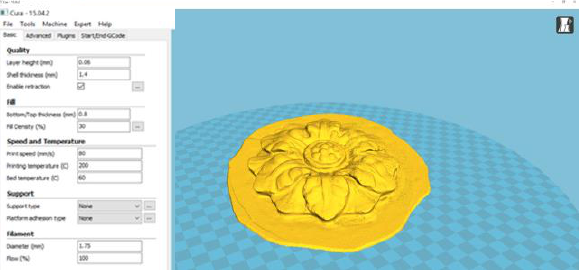
Figure 18. Setting parameters for 3D printing.